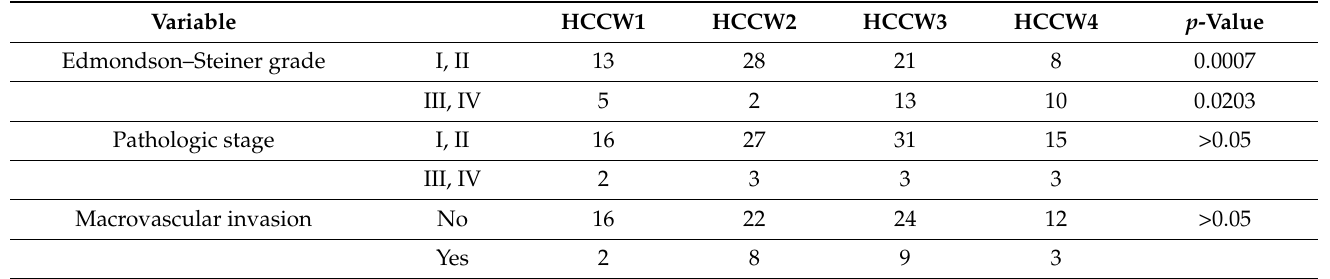
Table 1. Association between molecular subgroups HCCW1–4 and clinical